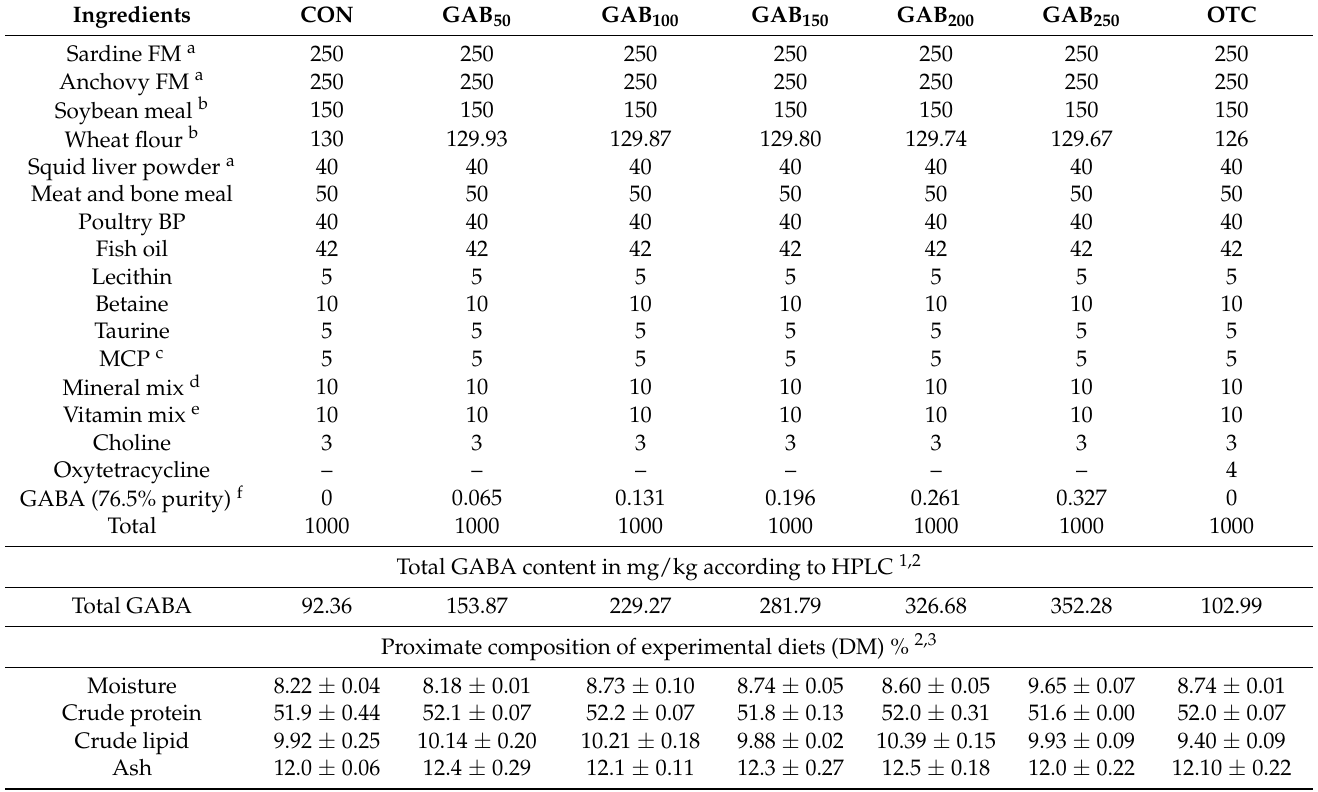
Table 1. Formulation of the seven experimental diets † supplemented with different levels of γ - aminobutyric acid (GABA) and fed to olive flounder for eight weeks (g/kg dry matter (DM)